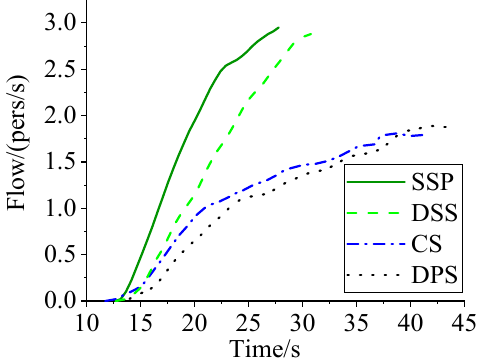
Figure 8. Real-time crowd flow of 50 evacuees on one floor.